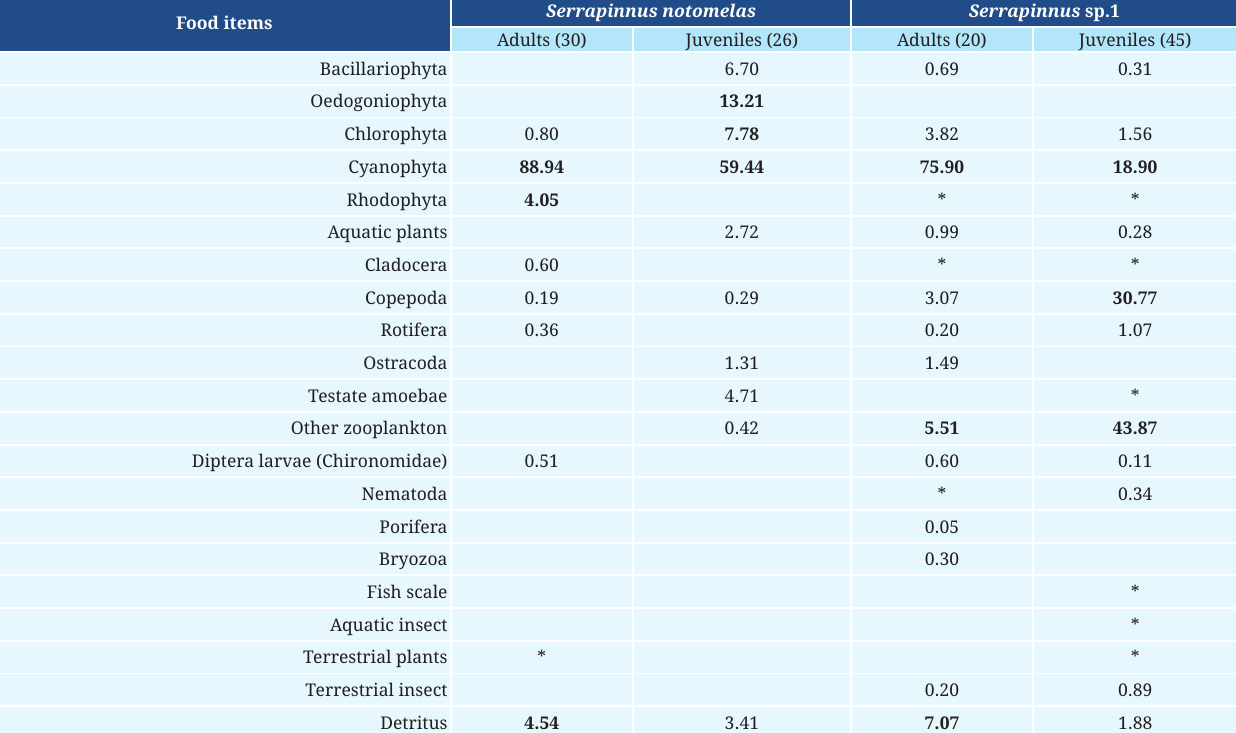
TABLE 1 | Food items consumed by juveniles and adults of Serrapinnus notomelas and Serrapinnus sp.1 in a lake in the upper Paraná River floodplain, Brazil. In parenthesis there are the number of analyzed stomachs. Values are based on the percentage data of the volume of food items. *Represents values less than 0.01. The most consumed food items are in